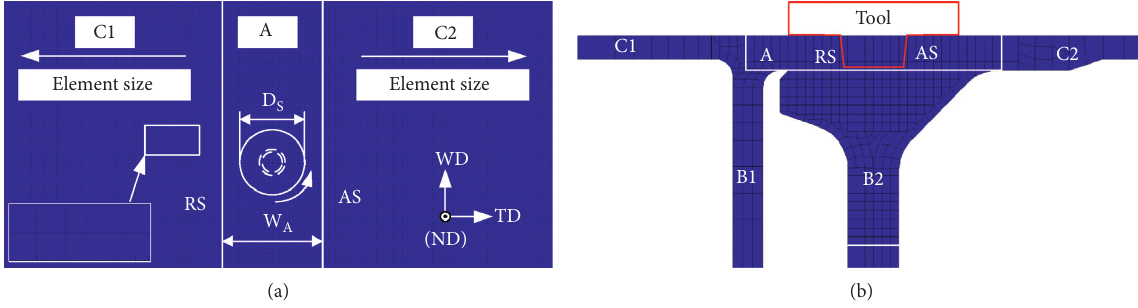
Figure 4: Grid mesh of the established thermal model in different views. (a) Top view; (b) front